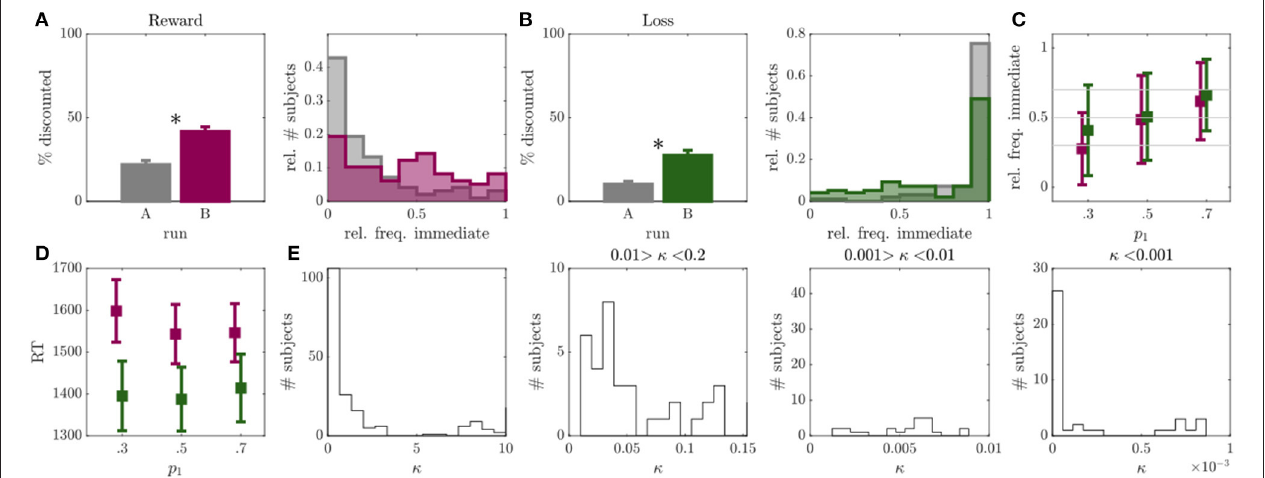
FIGURE 2 | Results of experiment 1. (A) Left: Percentage of discounted choices in run A (gray) and run B (magenta) for reward condition. Right: Histograms over relative frequency of immediate choices in run A (gray) and run B (magenta) for reward condition. Asterisks indicate significant differences. (B) Same as A for loss condition with run B displayed in green. (C) Mean and standard deviation of observed relative frequency of immediate choices for the experimentally evoked probabilities p 1 = {0.3, 0.5, 0.7} ( x -axis) in run B (individuals with > 95% or < 5% immediate choices were removed, N = 28 or 29% in reward, N = 52 or 53% in loss condition). (D) Mean and standard deviation of median reaction time (RT; y -axis) for p 1 = {0.3, 0.5, 0.7.} trials ( x -axis) in run B for reward (magenta) and loss